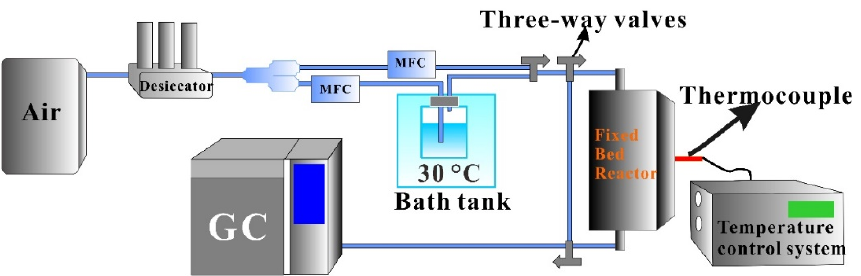
Figure 17. Schematic diagram of the catalytic evaluation system. MFC denotes mass flow meter, and the reaction tube size is 4 mm.